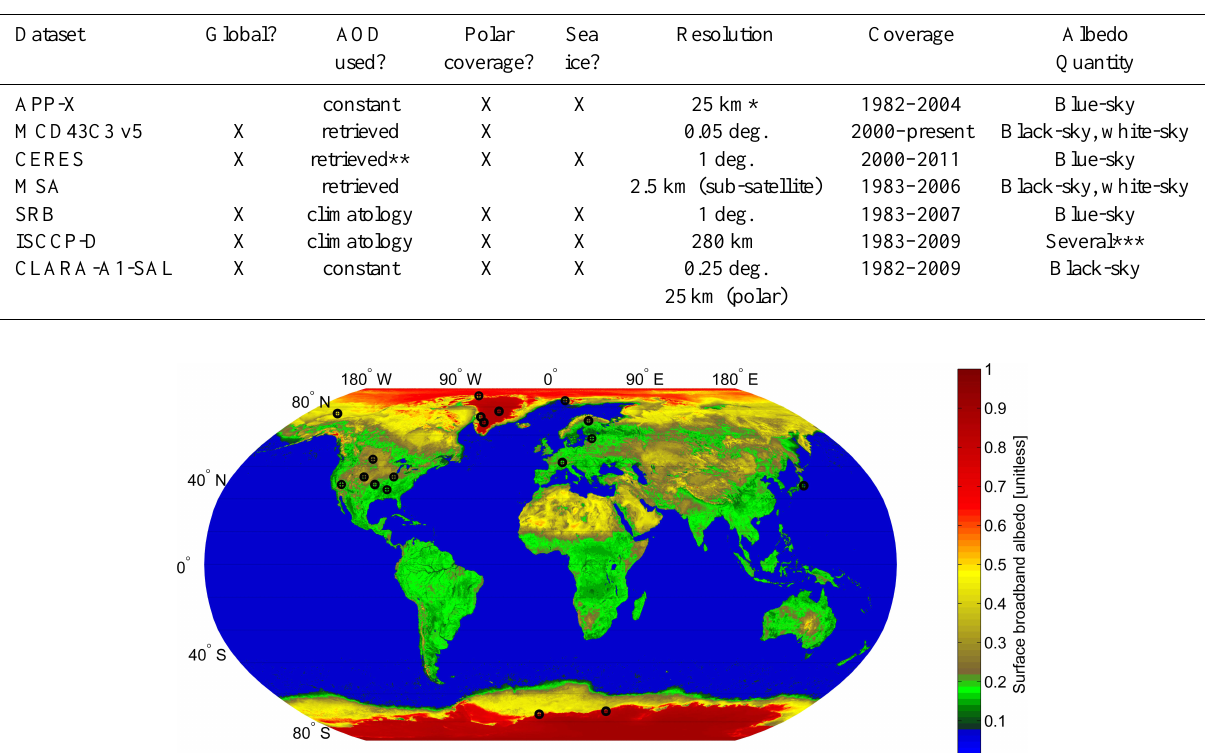
Table 1. Comparison of attributes of different long-term albedo datasets. ( ∗ APP-X being extended to 5 km resolution, ∗∗ MODIS AOD used, ∗∗∗ Blue-sky, clear-sky, overcast-sky, black-sky available.)